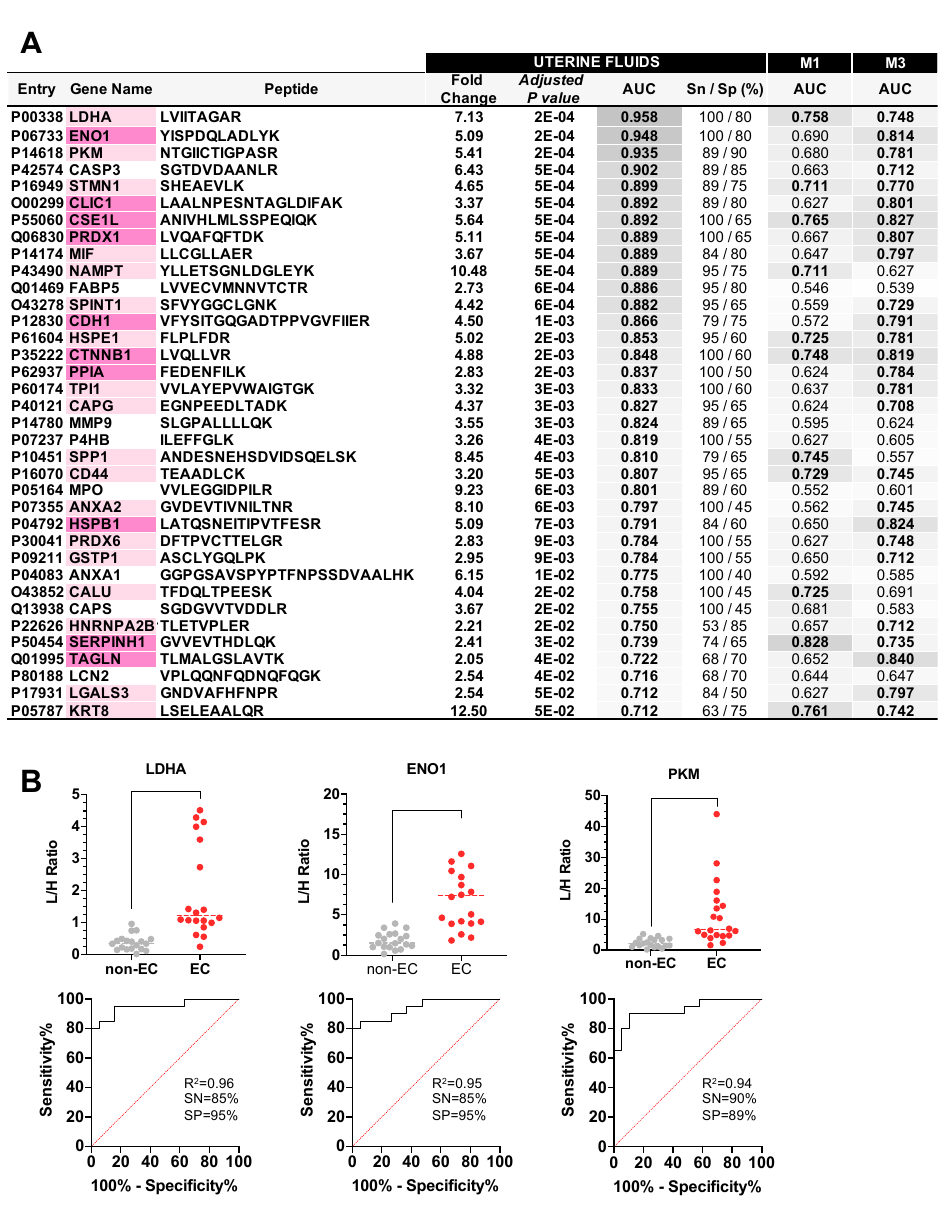
Figure 4. Proteins showing significantly different levels in uterine fluids from EC (n = 20) and non-EC women (n = 19). ( A ): Statistical results of the 36 proteins presenting an FDR < 0.05, Fold Change > |2| and AUC > 0.7 in the raw uterine fluids from the verification study (n = 39) when comparing EC vs. non-EC women. AUC values for the same proteins measured in M1 and M3 cervical fluids are also shown. AUC values are graded in grey according to their discriminative power. Proteins that demonstrated their diagnostic potential also in cervical fluids are highlighted in pink (AUC > 0.7), and in dark pink the ones with AUC values higher than 0.8 in cervical fluids. ( B ): Dot plots of the top three performing proteins representing the light/heavy ratios (L/H) obtained by LC-MS/MS PRM when analyzed in raw uterine fluids, and their corresponding ROC curve and sensitivity and specificity values. SN: sensitivity; SP: specificity.